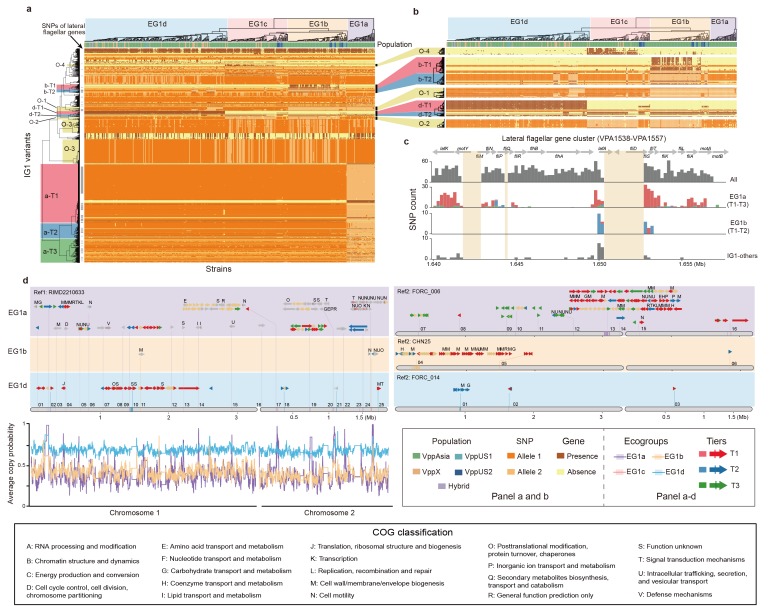
The largest interaction group (IG1) in V. parahaemolyticus.(a, b) Hierarchical clustering of 469 non-redundant strains (columns) based on coadaptated loci (rows) of IG1. Colors of the heatmap indicate the status of genetic variants as shown in the legend (bottom right), background colors of the upper and left clustering tree separately indicate different ecogroups (EG) and tiers, respectively, matching the colors in panel b-d. Colored bars below the upper clustering tree indicate the populations of strains. SNPs of lateral flagellar genes were marked by grey bars on the left of the heatmap. Panel b is a zoom-in version of specific tiers in panel a. (c) The distribution of coadaptation SNPs in the lateral flagellar gene cluster region (VPA1538-1557). The top indicates the gene organization of lateral flagellar gene cluster. Light orange rectangles indicate regions in the accessory genome. The histograms indicate the distribution of SNPs along the gene cluster, with colors of bars indicating coadaptation tiers. (d) Coadaptation blocks of IG1, shown in their genomic locations. Four different reference genomes were used, as indicated on the top of each panel, since no single genome contains all of the accessory genome variants. Grey horizontal arrows indicate core genes. Accessory genes are colored according to their tier or are tan if they do not belong to one. Vertical colored bars within grey arrows indicate core-SNPs in IG1, with colors indicating different coadaptation tiers. COG classification labels are shown above the genes. The numerical labels above reference genomes indicate the identity of the coadaptation genome blocks, corresponding to the information in Supplementary file 1. Colors of bottom left curves indicate the average copying probability (probability of genetic variants inherited from the same ecogroup) of different EGs calculated using chromosome painting.